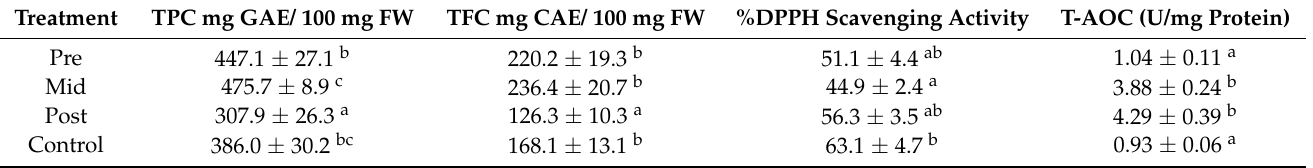
Table 2. Blanching effect on the contents of total polyphenols, flavonoids, DPPH, and total antioxidant capacity (T-AOC) in the stem of water